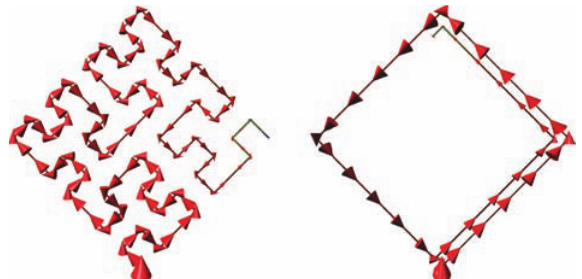
F 13: Current vector distribution of the antennas at the resonance frequency of 𝑓𝑓 = 84.5